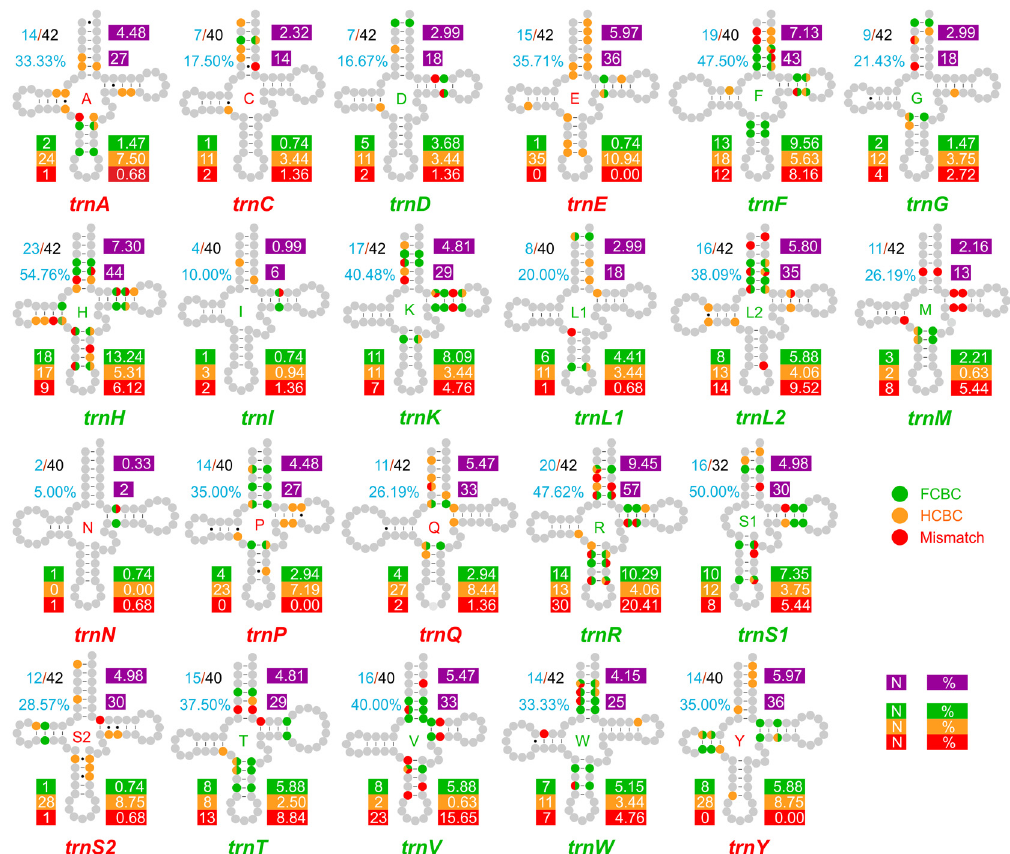
Fig 3. Distribution of CSBPSs in a single tRNA. CSBPS, change in sequence in a base pair of a stem; FCBC, fully compensatory base change; HCBC, hemi compensatory base change; Mismatch, mismatch in a base pair of a stem; SPIC, stem position involved in base change. The number/percentage of SPICs is provided in cyan. A green background is used to mark the number of FCBCs occurring in a tRNA as well as the percentage that they represent with respect to the total number of FCBCs. The orange and red backgrounds are used for the number/percentage of HCBCs and Mismatches. A purple background is used for number/percentage of